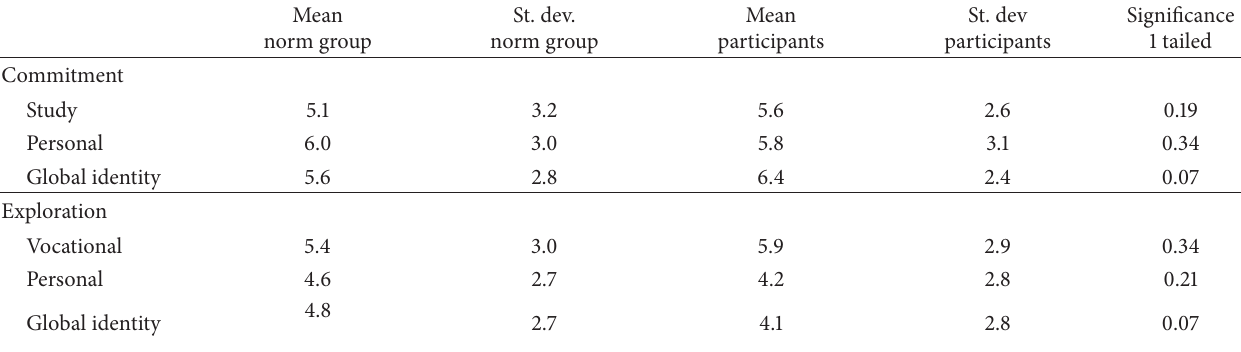
Table 3: Commitment and exploration per domain of the participants after the guidance ( 𝑛 = 45 ) as compared to the norm group ( 𝑛 = 93 ) (decile scores).